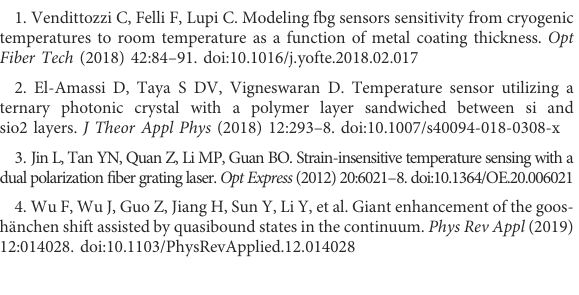
Figure 9, the demodulated curves for both responses in the experiment changed in the same way with the theoretical ones. The mean relative errors of temperature and strain responses were computed to be 3.476 and 1.087%, respectively, which separated the cross sensitivity between temperature and strain.